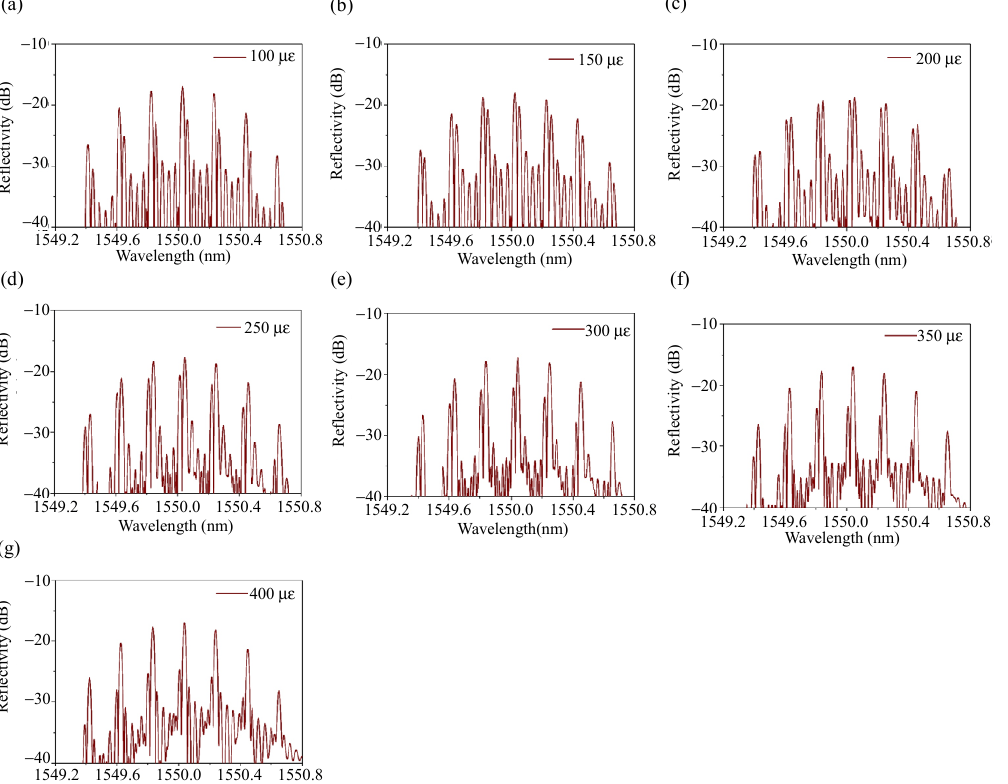
Fig. 8 Reflection spectra with different strains: (a)–(g): 100 μɛ – 400 μɛ